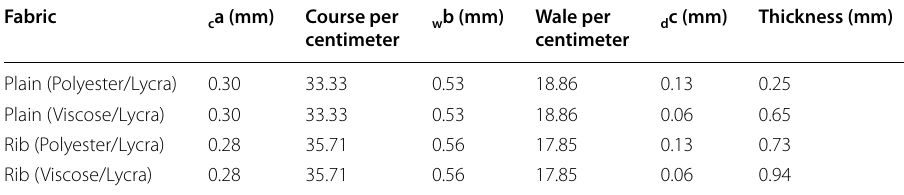
a Distance Between Two Consecutive Courses, b Distance Between Two Consecutive Wales, c Yarn Diameter